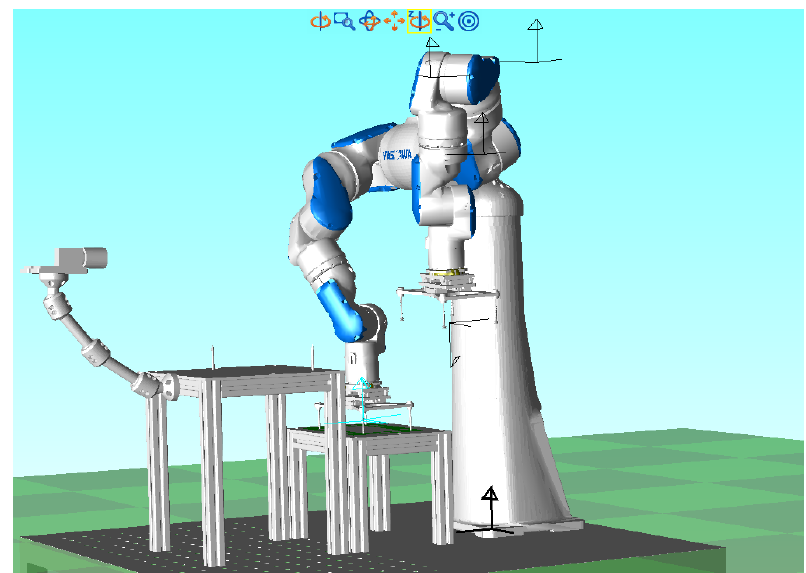
Figure 9. Robot hands operating in coordinated manipulation mode to flip the fuel cell component.